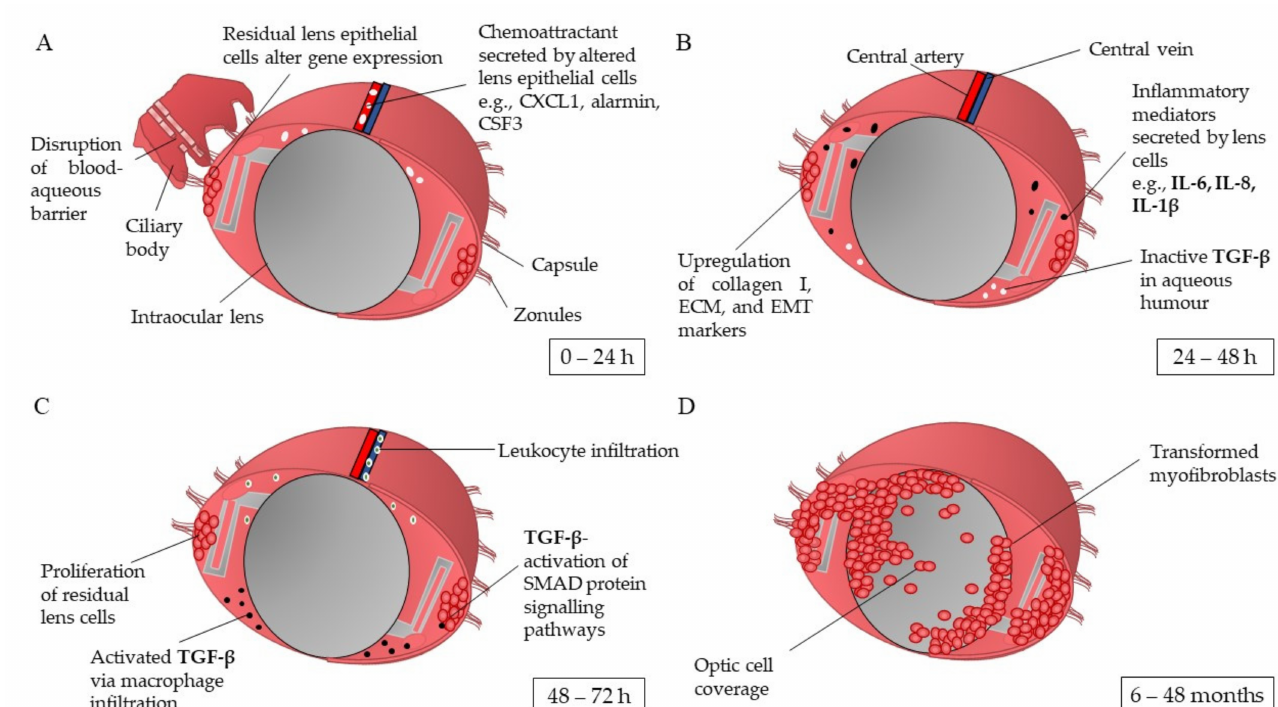
Figure 1. Schematic overview of the capsular bag post cataract surgery in the development of posterior capsule opacifi- cation. ( A ) Stimulated by surgery trauma, residual lens epithelial cells undergo the wound healing response, alteration of gene transcriptome and expression of chemoattracts targeting inflammatory mediators and innate immune cells. ( B ) Upregulation of inflammatory mediators, i.e., IL-1 β expressed by lens cells undergoes autocrine signalling to initiate the synthesis of collagen I, extracellular matrix (ECM), and epithelial-mesenchymal transition (EMT), proteins and markers. ( C ) Residual lens epithelial cells start to proliferate; leukocyte infiltration attracted by the high levels of chemo attractants and inflammatory mediators activate dormant transforming growth factor beta (TGF- β ) residing in the aqueous humour. TGF- β activates SMAD3 signalling pathways in the lens cells, stimulating PI3/Akt, Rho GTPases, and MAPK pathways. ( D ) The transdifferentiated lens cells migrate over the intraocular lens’ optic. IL: interleukin; TGF- β : transforming growth factor beta